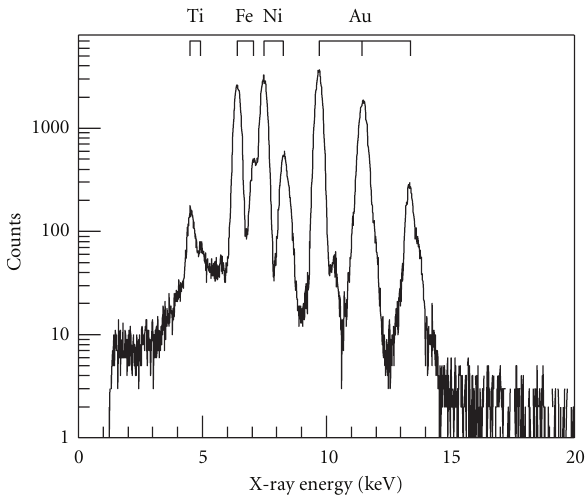
Figure 1: A PIXE spectrum of a NiFe thin film deposited from a 100mM NiSO 4 , 10 mM FeSO 4 , 0.5M H 3 BO 3 , and 1M Na 2 SO 4 solution at − 900mV for 6min. Approximately 1.8 μ C of 3.4MeV protons were incident on the sample to obtain this spectrum. The peaks corresponding to the K X-rays of Ti, Fe, and Ni, and the L X-rays of Au are indicated.